Question: How would you classify this visualization?
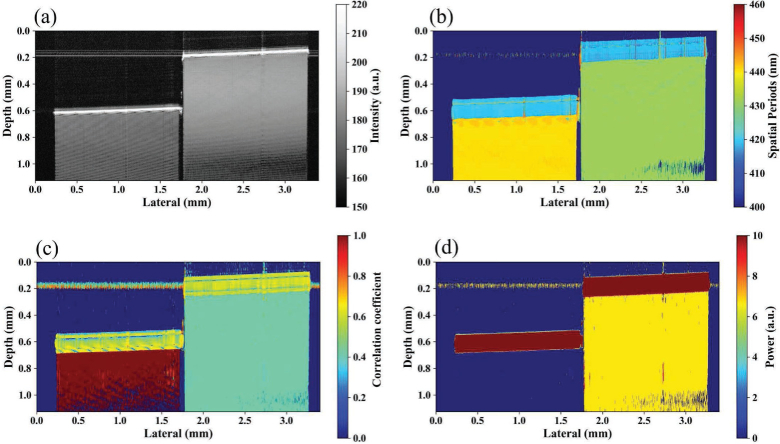
Answer: scatter